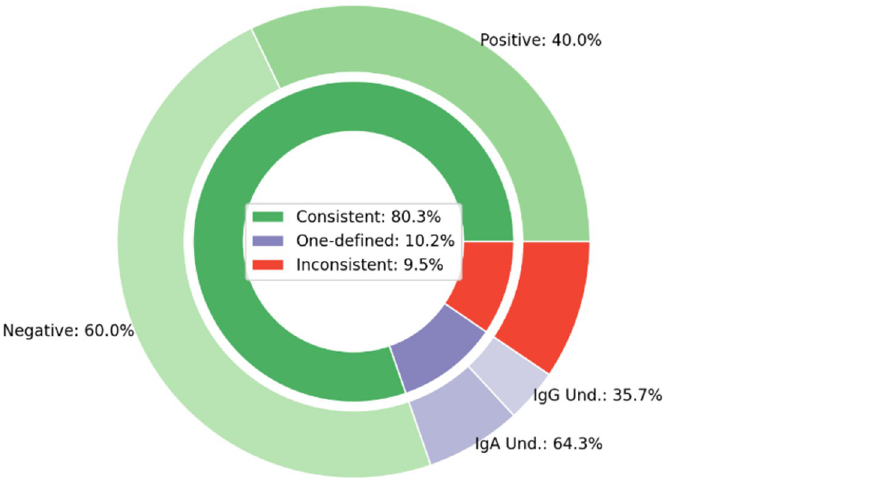
Fig 3. Convergence of results from IgA and IgG tests for the same sample.